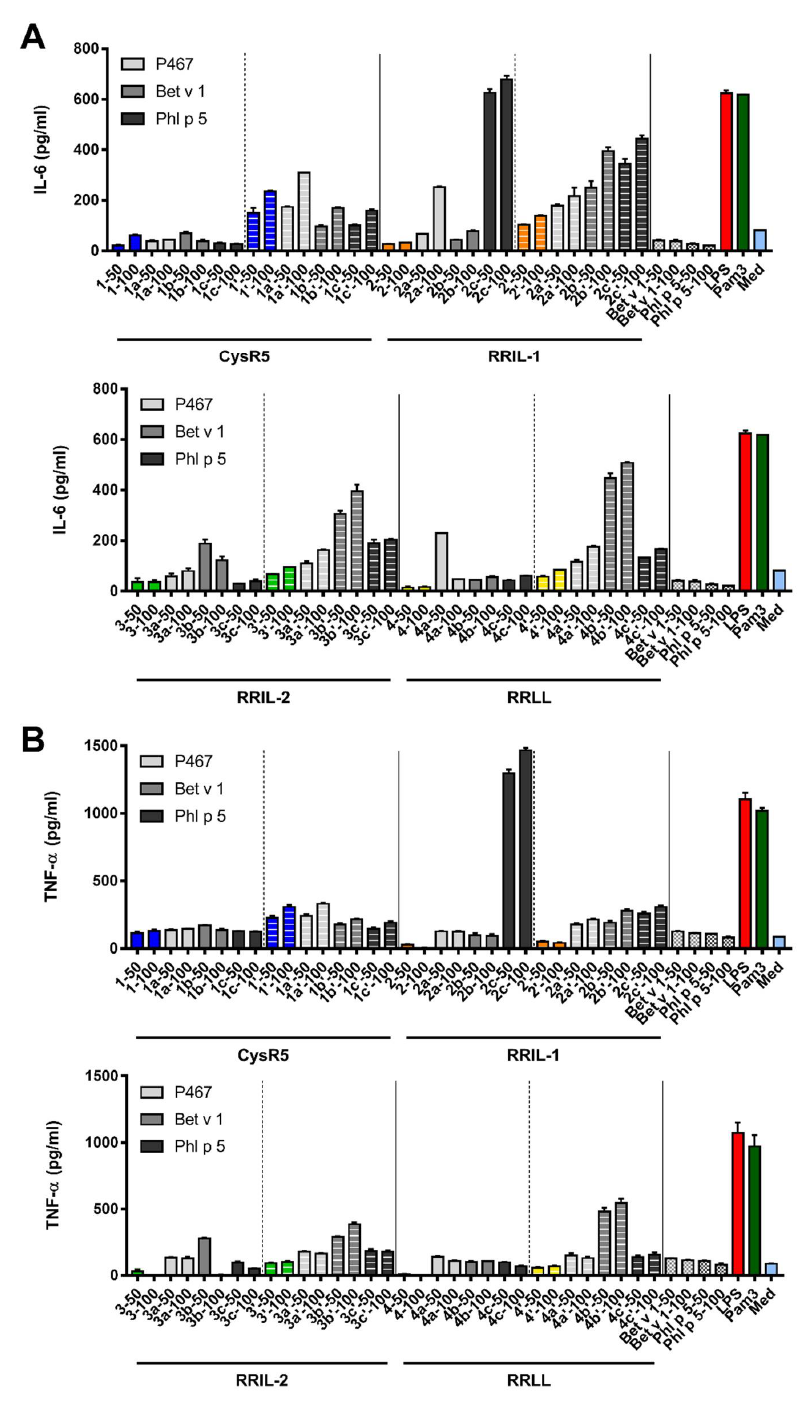
Figure 8. IL-6 ( A ) and TNF- α ( B ) secretion by murine bone marrow-derived dendritic cells in response to 50 µ g and 100 µ g of the silica-precipitating peptides, peptide–antigen conjugates and to silica particles produced from the conjugates was employed to assess their immunostimulatory effects. CysR5-related structures are displayed in blue, RRIL-1-related structures in orange, RRIL-2-related structures in green and RRLL-related structures in yellow. LPS (red) and PAM3 (dark green) were used as positive controls and medium (light blue) as negative control.